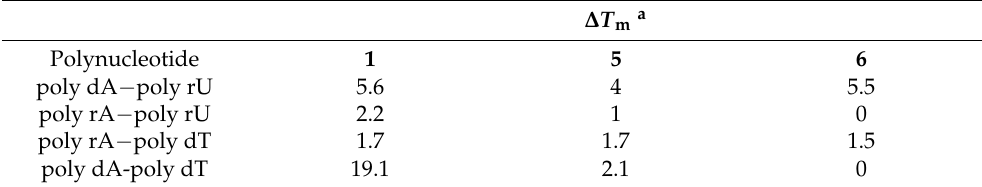
= 65.3 ◦ C; poly dA-poly dT = 70.6 ◦ C.; c r = [compound]/[polynucleotide]. d All measurements were done at pH 7.0 (sodium cacodylate buffer with NaCl, I = 0.1 mol dm − 3 + 1 mM